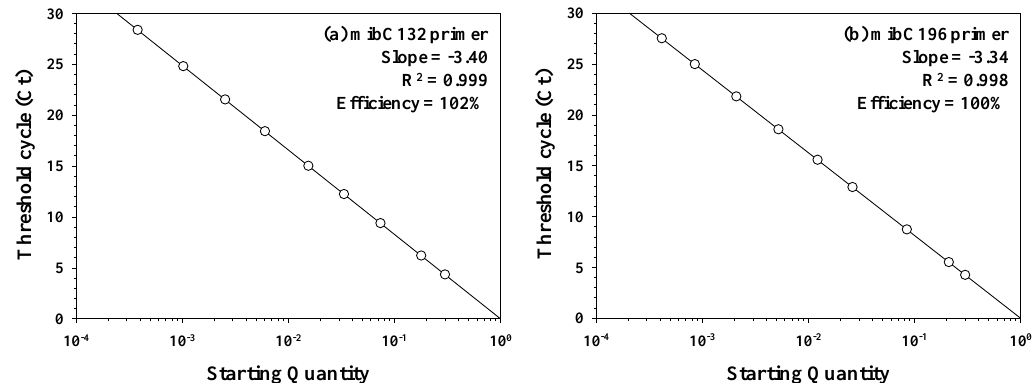
Figure 5. Standard curve for real-time PCR analysis with serial ten-fold-diluted DNA, which was cloned from the mibC gene fragment. Primer sets of ( a ) mibC132 and ( b ) mibC196 were used for SYBR type polymerase.